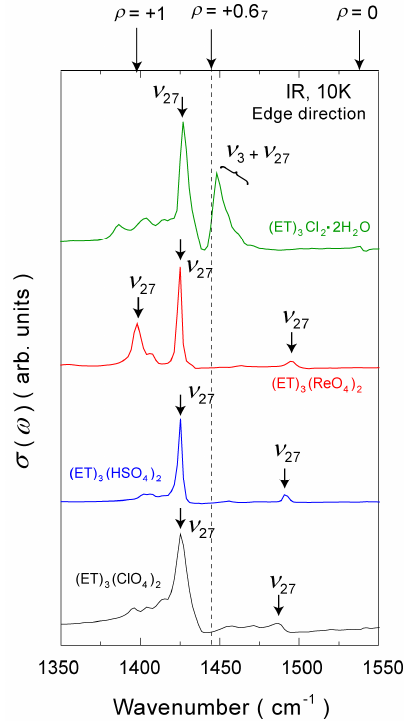
mode in each 2 is shown as the arrow and 7